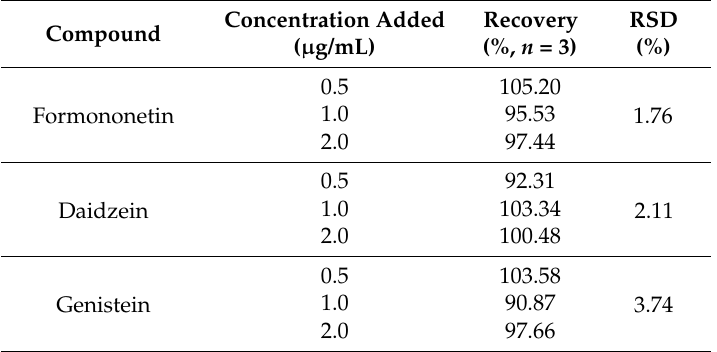
Table 2. Recoveries for the determination of the three isoflavones in